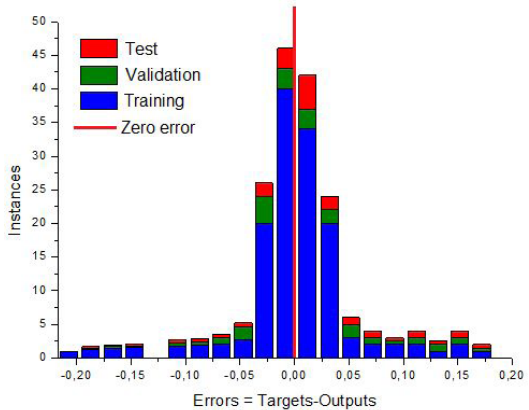
Figure 11. Error histogram of the MLP-ANN with 20 Bins for CIE chromaticity of CoHo:PGLyD microspheres recognition.